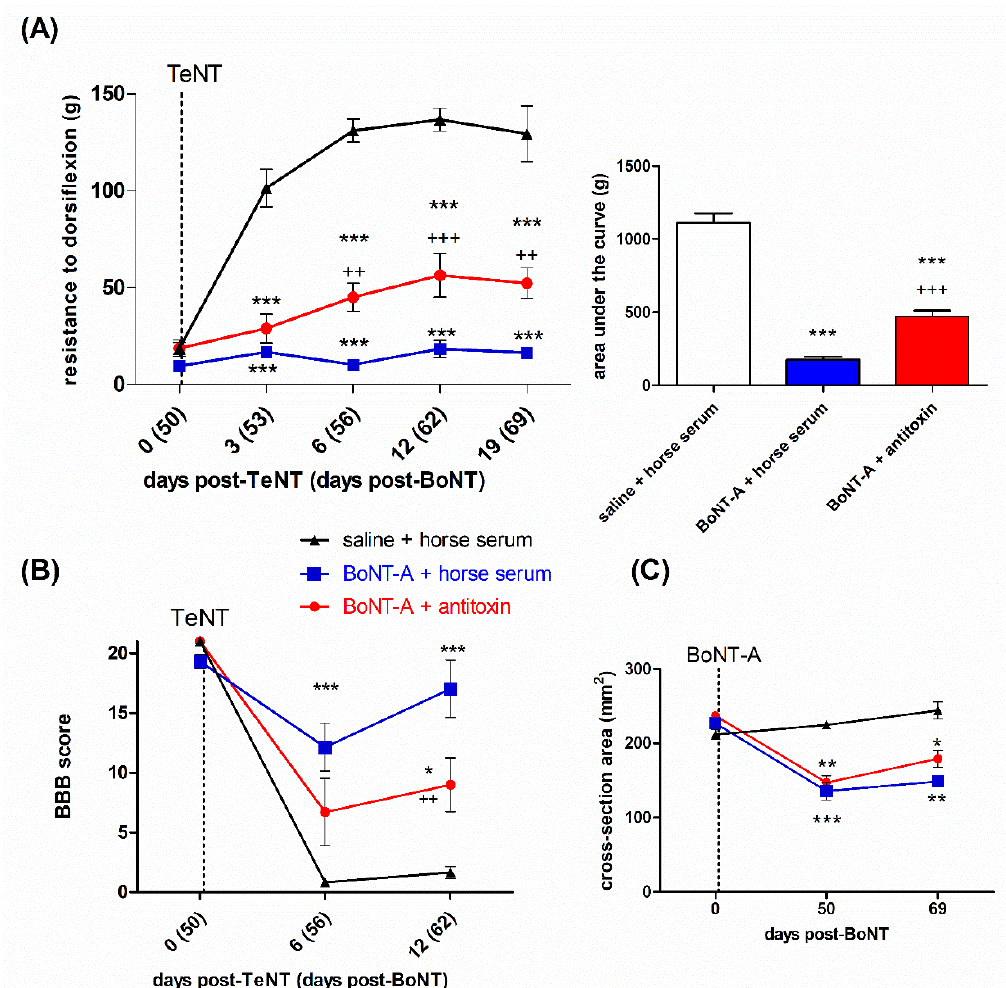
Figure 4. The late BoNT-A antispastic effect involves transcytosis-dependent central action. The rats were treated with i.m. BoNT-A (5 U/kg) and, then, after 24 h, injected i.t. into the lumbar spinal canal with the neutralizing equine antitoxin (or horse serum as the control) to prevent its central transcytosis-dependent action. Then, after a further 49 days, its effect on the TeNT (1.5 ng, i.m.)-evoked local muscle spasm was assessed by measuring the resistance to ankle dorsiflexion (reaching a 90° tibiotarsal angle) ( A ) and the locomotor deficit assessed by the BBB scale ( B ). The central toxin action does not affect the atrophic loss of the lower leg estimated cross-sectional area at the widest calf point ( C ). Sal, saline i.m. treatment. Horizontal bars indicate the time points of TeNT i.m. application. N = 6 to 7 animals/group; mean ± SEM, *, ** and ***: p < 0.05, <0.01 and <0.001 vs. sal + horse serum, ++ and +++: p <0.01 and <0.001 vs. BoNT-A + horse serum (two-way RM ANOVA, followed by Bonferroni’s post hoc test; p < 0.05 considered significant).